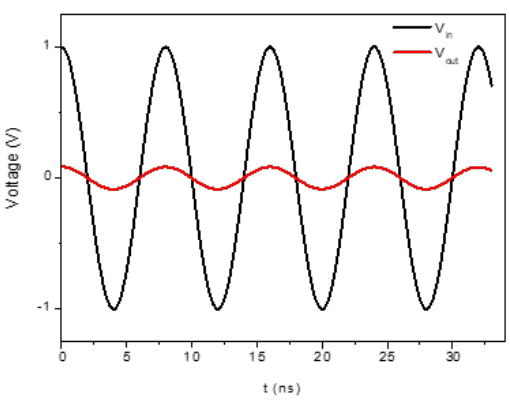
Figure 9. The input and output voltage vs. time curves for the Rayleigh mode.